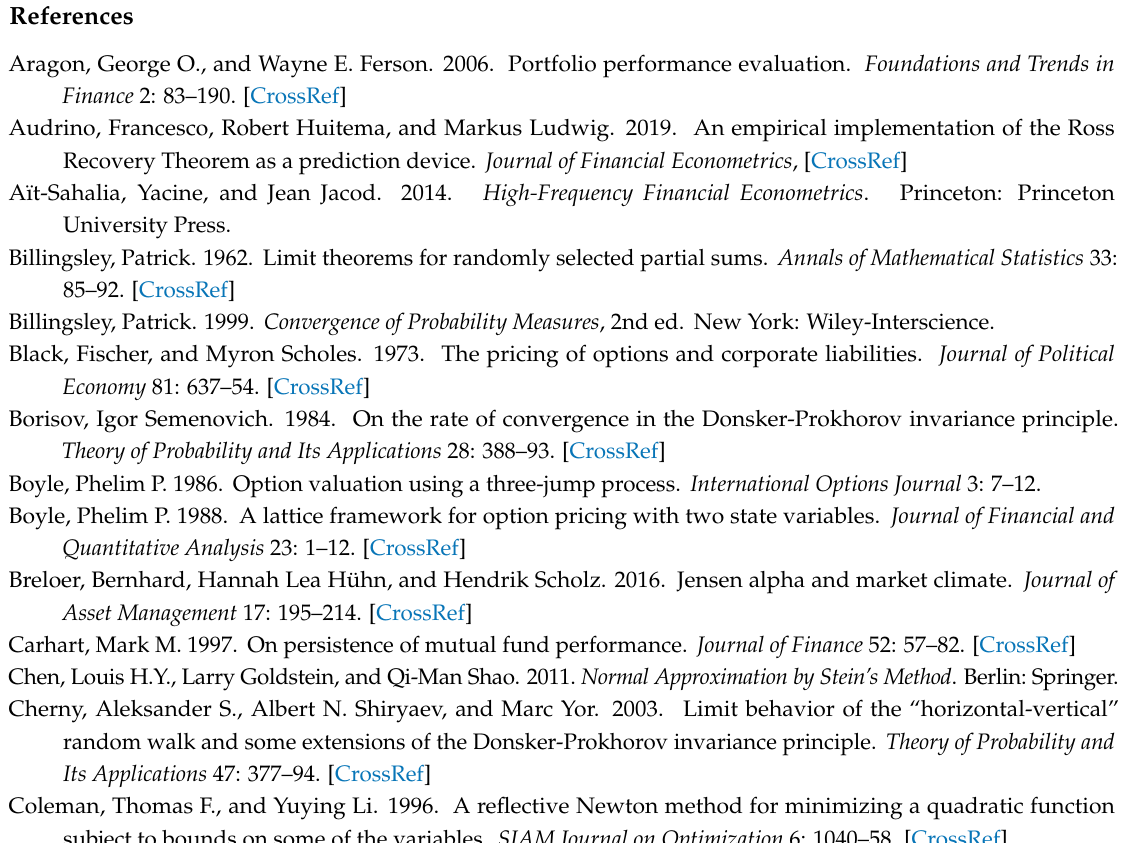
( n , h , g , S ) computed from the continuum t